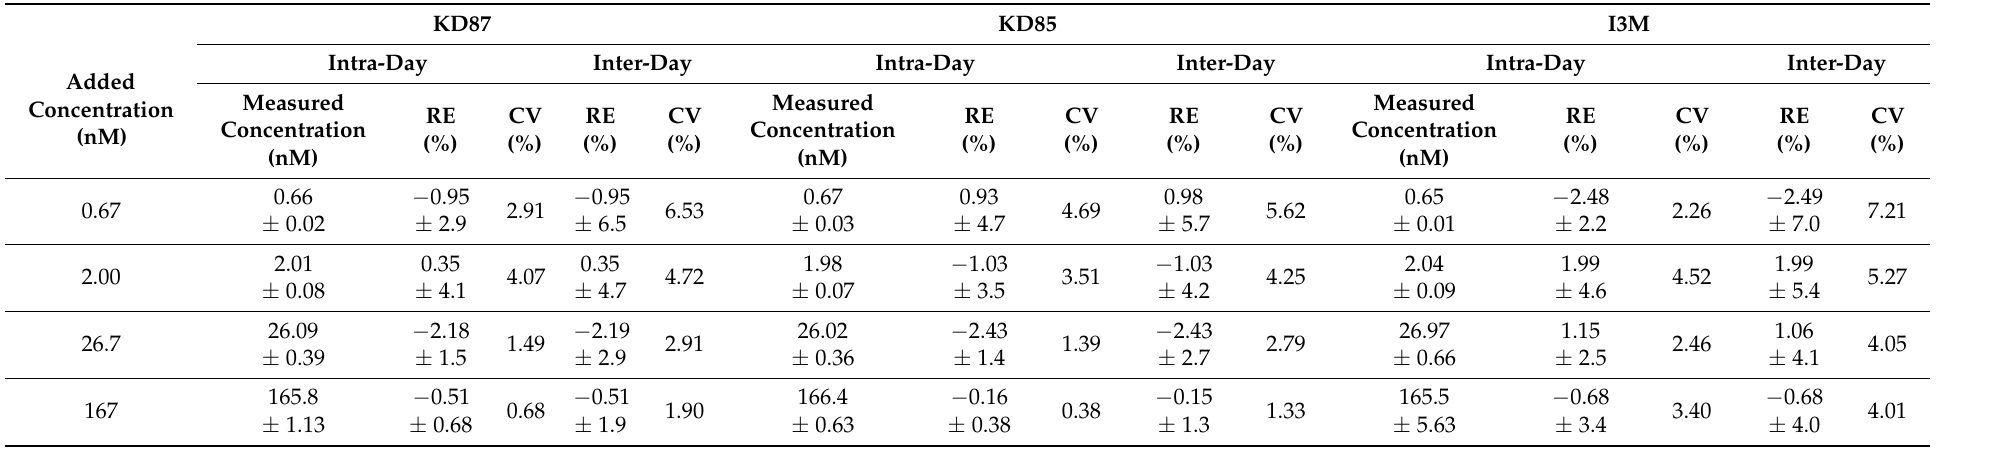
Table 2. Inter- and intra-day accuracy, expressed as relative error (RE) ± standard deviation (SD), and precision, determined as coefficient of variation (CV), of different samples each from four days of KD87, KD85, and I3M at LLOQ level (0.67 nM), low (2 nM), medium (26.7 nM), and high (167 nM) concentrations